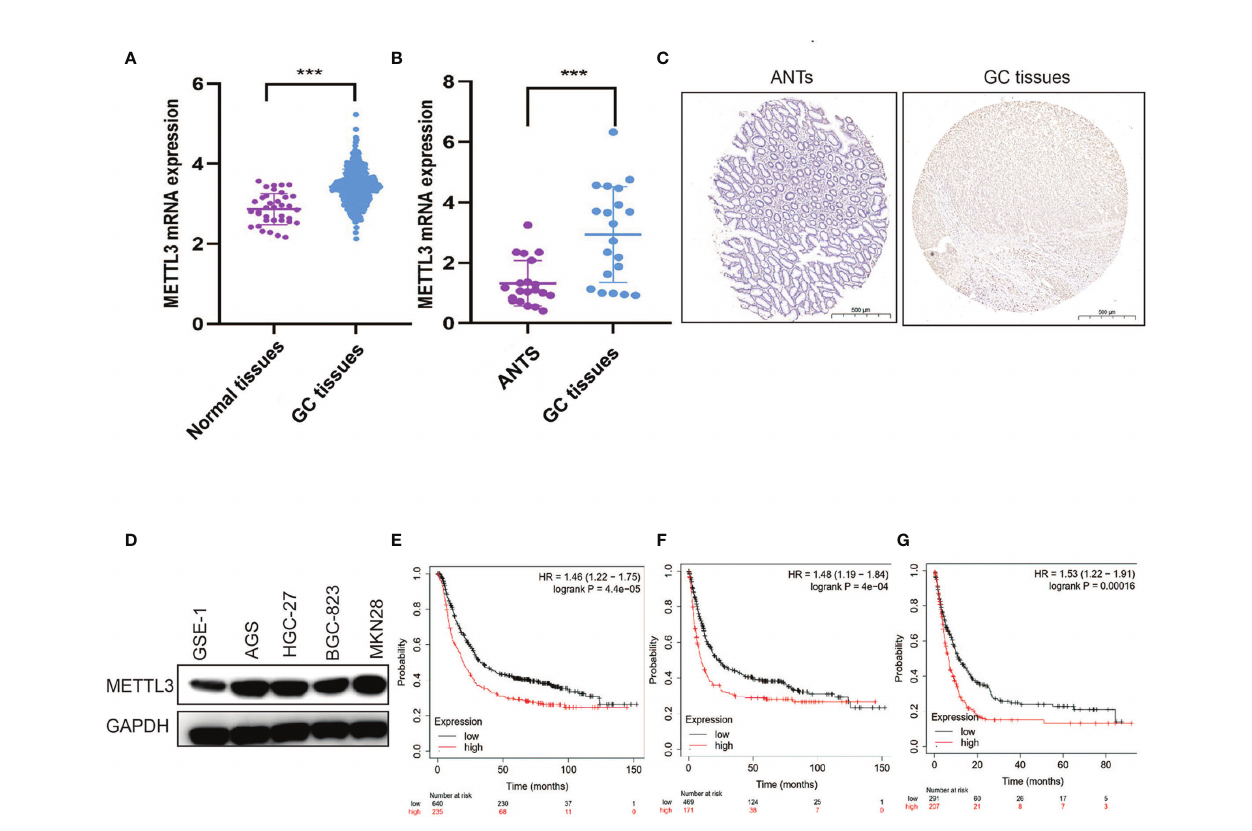
FIGURE 1 | METTL3 is overexpressed and related to poor prognosis in GC. (A) METTL3 mRNA expression was evaluated in TCGA GC cohort. (B) METTL3 mRNA expression was evaluated in clinical GC samples. (C) Representative IHC stains of METTL3 in clinical GC samples. (D) METTL3 expression was measured in gastric epithelial cell and GC cell lines. (E – G) OS (E) , PFS (F) , and PPS (G) were analyzed in GC patients according to METTL3 expression. ***P <